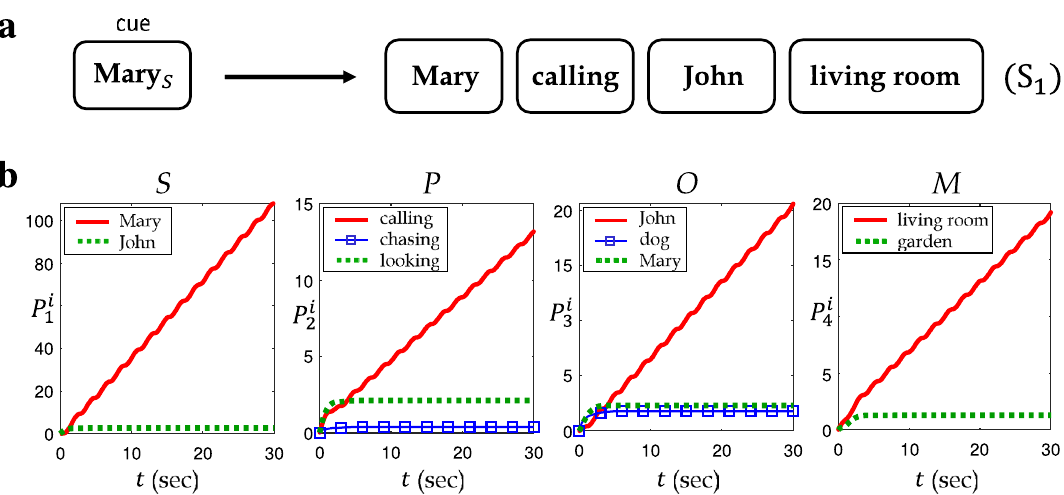
Figure 8. ( a ) Expected result of retrieval when the cue Mary S given. ( b ) The numerical result of retrieval by the cue Mary S . Dominant increasing values of P